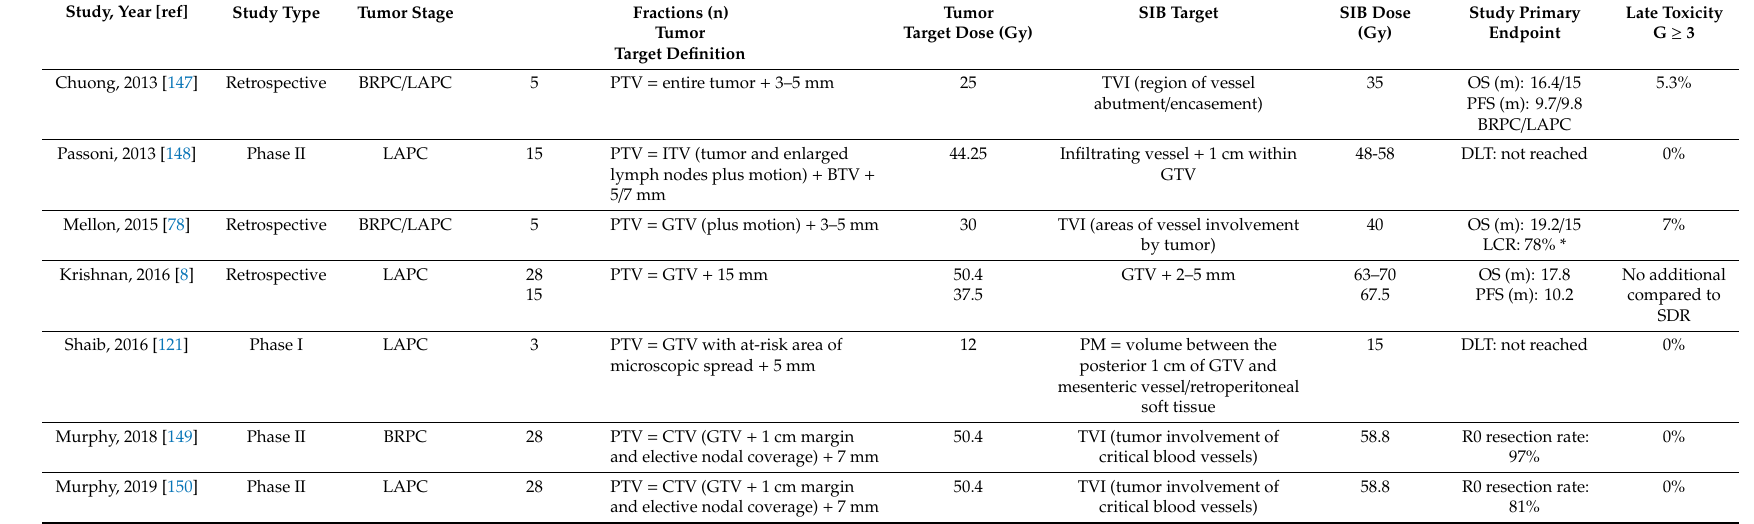
Table 5. Recent findings on the application of SIB on pancreatic cancer